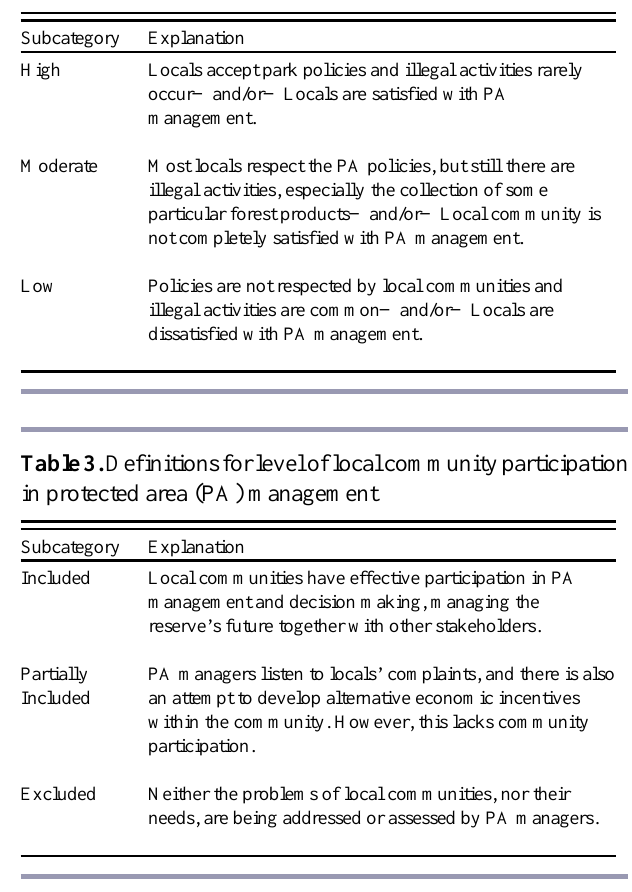
Table 2. Definitions for level of compliance of local